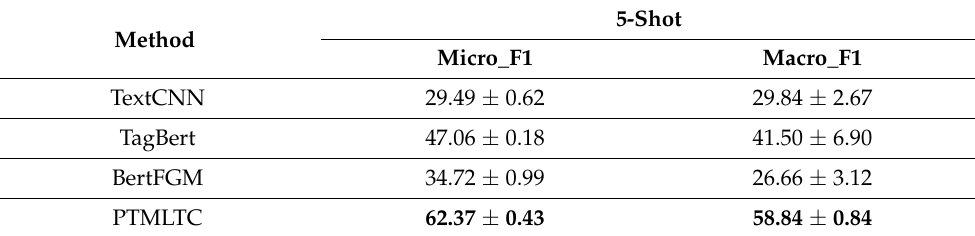
Table 3. Results of 5-shot on our dataset. Metrics marked in bold contain the highest metrics for the